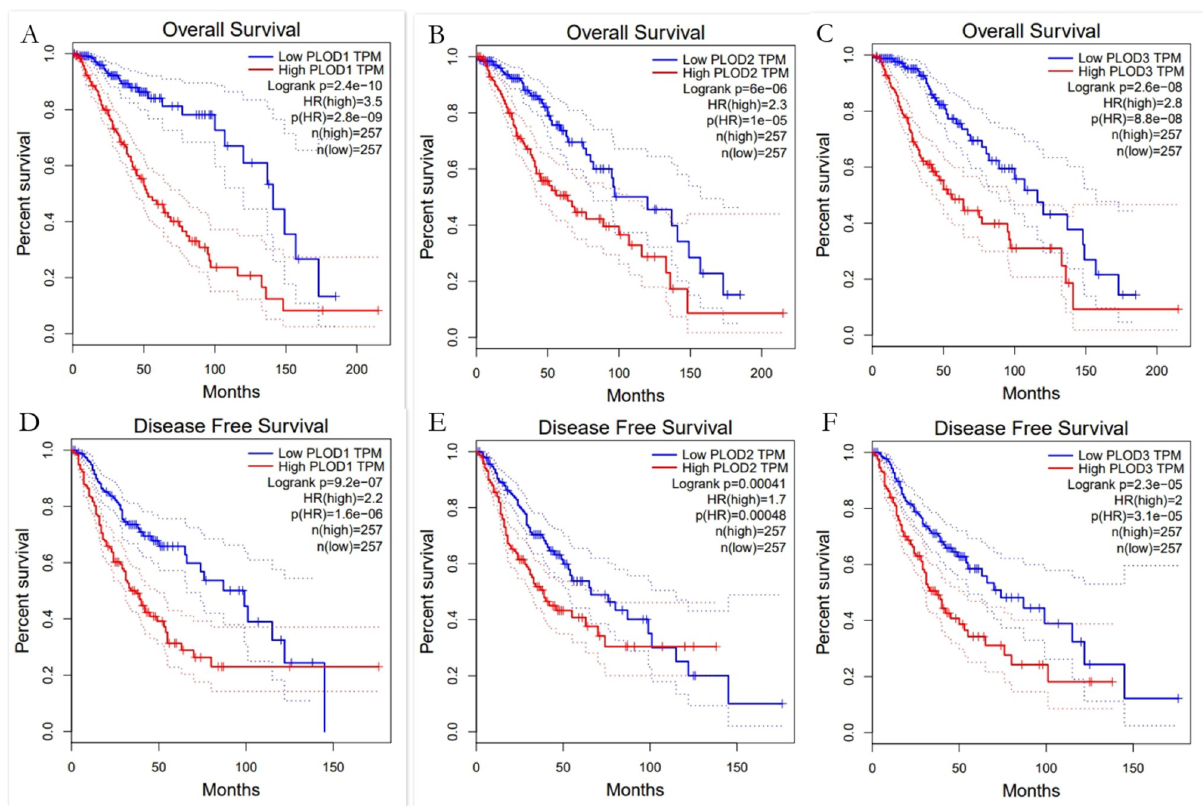
Fig 2. The survival analysis of PLOD family members in LGG. (A-C) Overexpression level of PLOD1, PLOD2 and PLOD3 were associated with shorter OS in LGG. (D-F) Overexpression level of PLOD1, PLOD2 and PLOD3 were associated with shorter DFS in